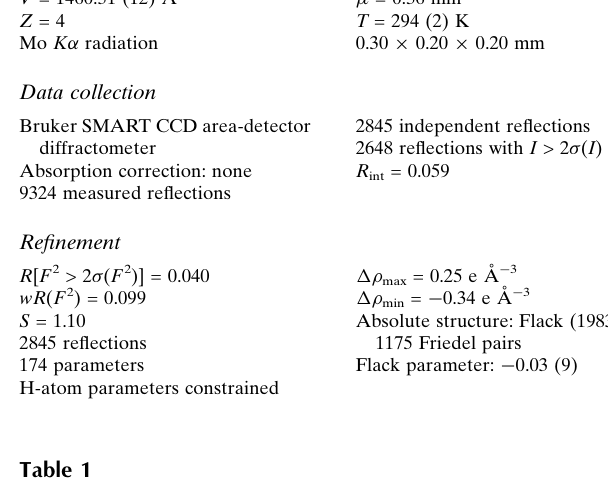
Hydrogen-bond geometry (A˚ , (cid:4)